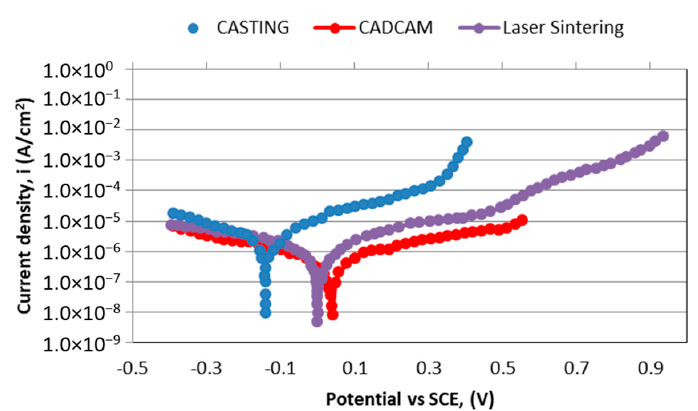
Figure 3. Polarization curves. Evans Diagrams for the samples studied.